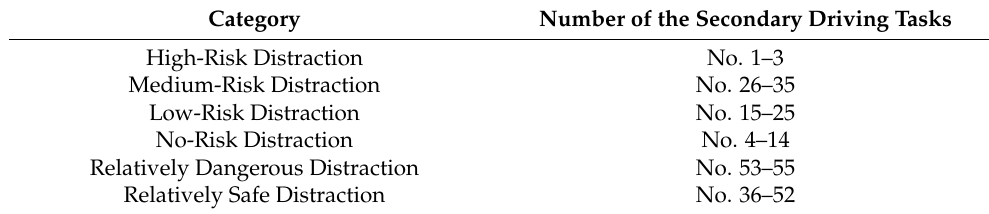
Table 7. Secondary driving task